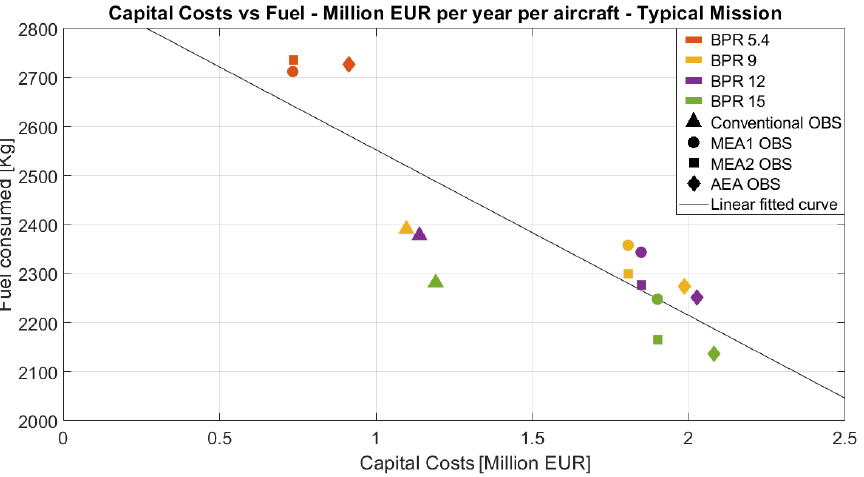
Figure 10. Fuel consumed during a typical mission and the capital costs represented by all the retrofitting solutions considered. The color of each point represents the engine BPR, while the shape (triangle, circle, square or diamond) represents the OBS levels of electrification.